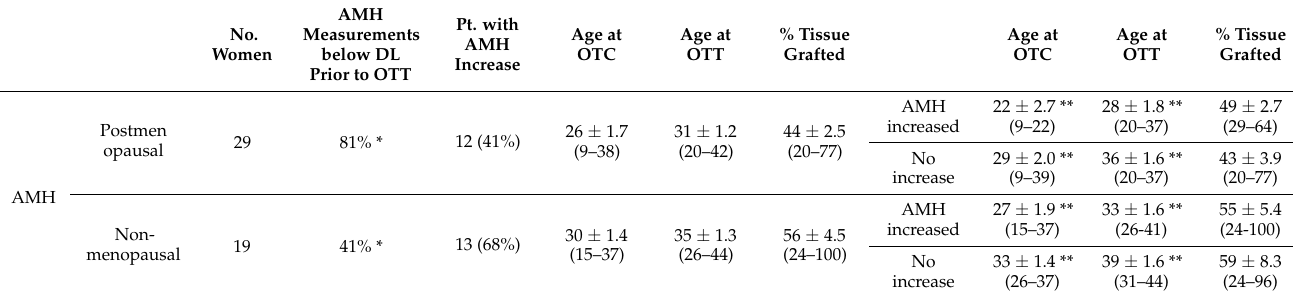
Table 2. Serum AMH concentrations of women transplanted with ovarian tissue in relation to menopausal status at the time of transplantation, age and amount of tissue